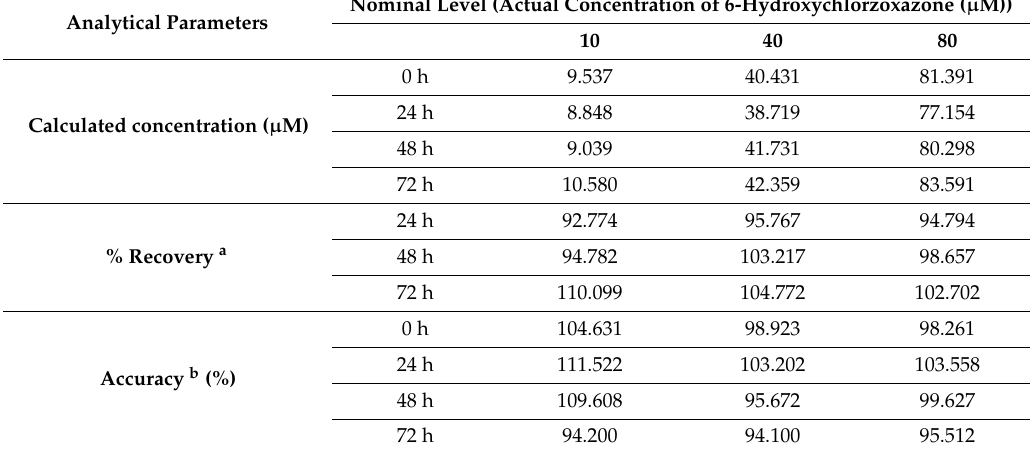
Table 8. Stability test data of